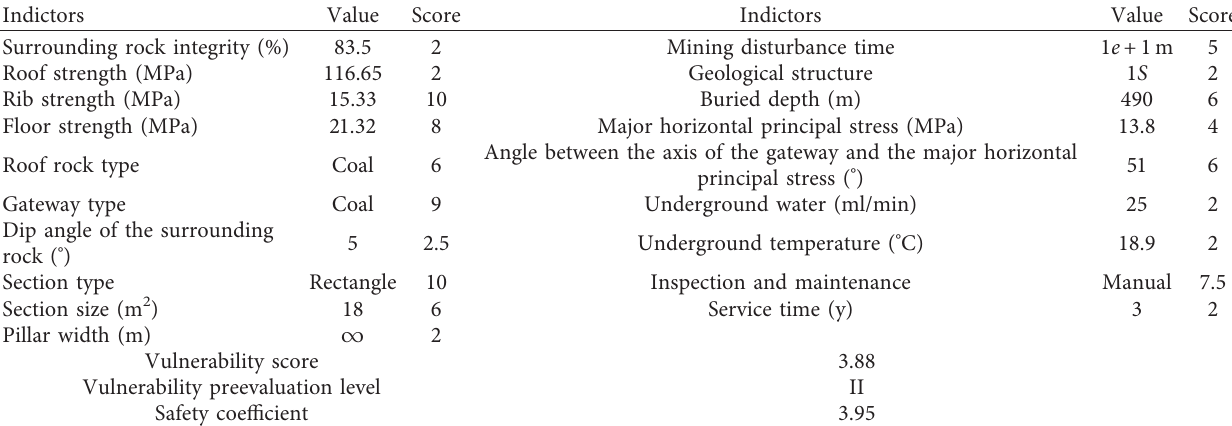
Table 24: The evaluation parameters and scores of tailgate N1303.